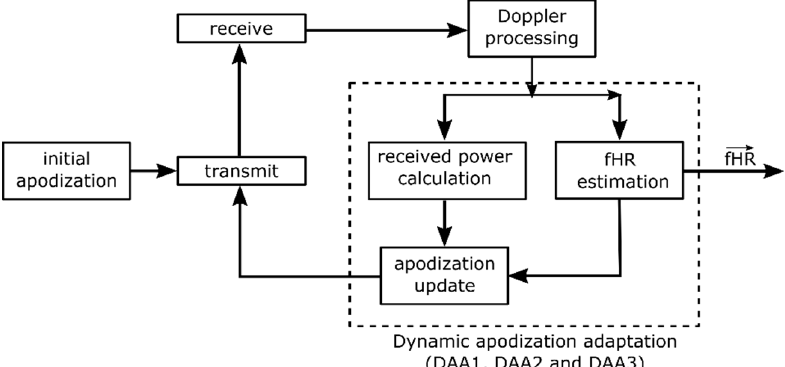
Figure 3. Block diagram of the dynamic apodization adaptation (DAA1, DAA2 and DAA3) process. An initial apodization is used in a first transmit-receive sequence. From the resulting Doppler signals, the power and fHR are estimated and used to update the apodization function, which modulates the transmission pulse of the next transmit-receive sequence.